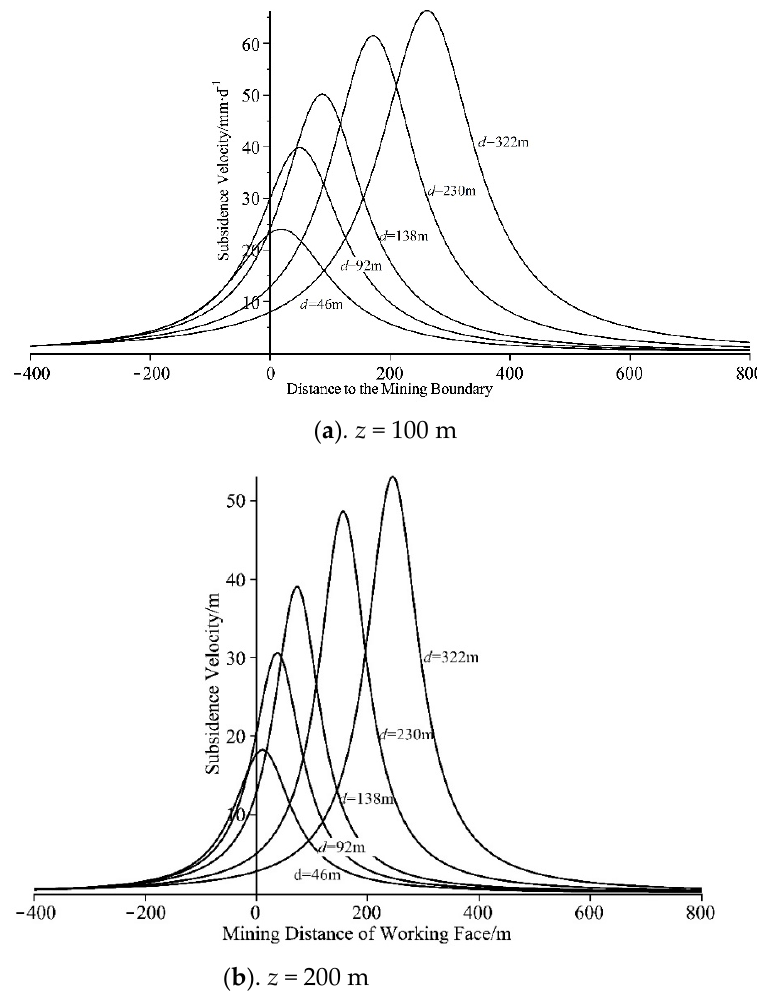
Figure 14. The time-dependent subsidence velocity of strata in different buried depths with mining.